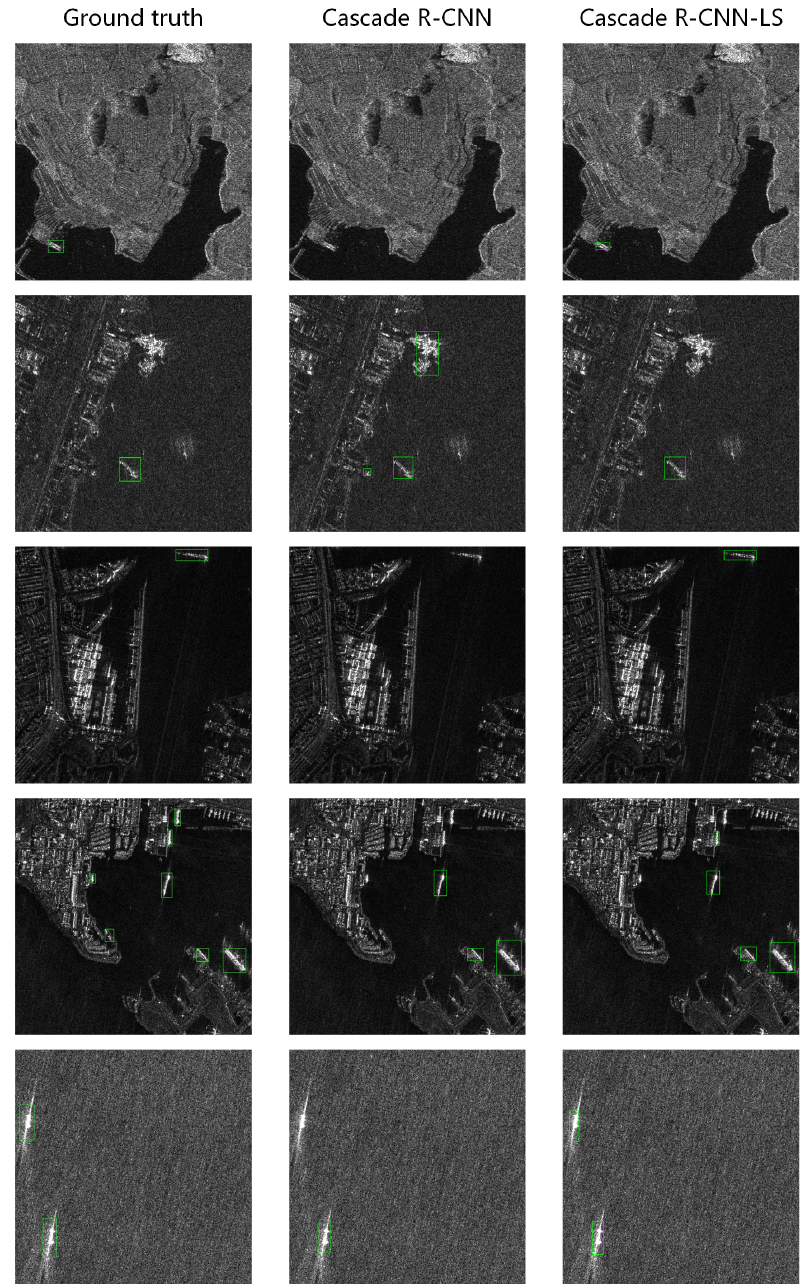
Figure 7. Detection results on AIR-SarSHIP-1.0 samples. The 1st column displays the samples from the ground truth, while the 2nd and 3rd columns are the detection results of the relative samples of Cascade R-CNN and Cascade R-CNN-LS, respectively. The lifting scheme-based network tends to detect small objects better than the strided convolution as the 1st and the 3rd rows